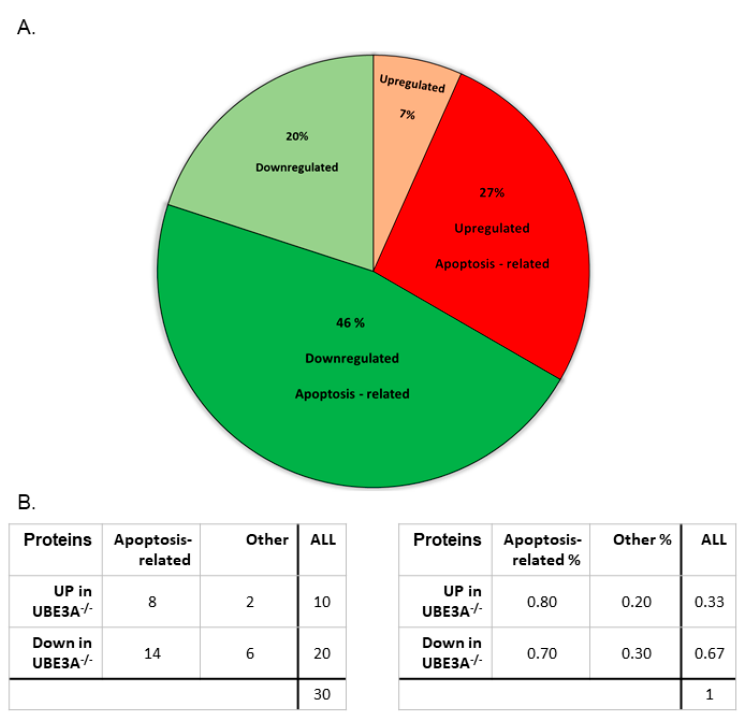
Figure 7. SILAC-based proteomics analysis. ( A ) Pie chart of differentially expressed proteins in Ube3a − / − MEFs. The threshold was set to an at least 20% change in both independent experiments. ( B ) Table of differentially expressed proteins in Ube3a − / − MEFs. From 10 upregulated proteins, we found that 80% ( n = 8) are associated with apoptosis. From 20 downregulated proteins, 70% ( n = 14) are associated with apoptosis.